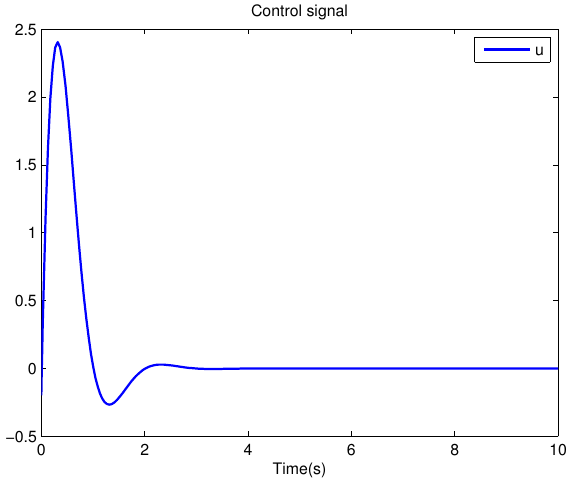
Figure 2. Robust control signal.